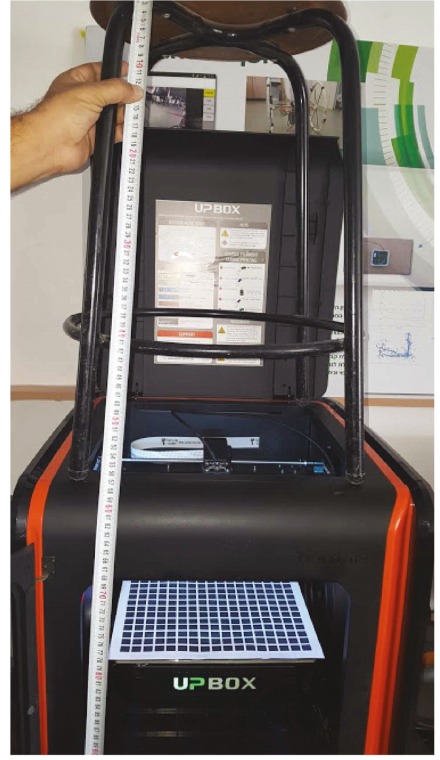
Figure 11: The camera calibration test setup. Using a calibrated 3D printer with a robotic moving panel, we were able to calibrate the Z approximation up to the 0 . 4mm accuracy level.